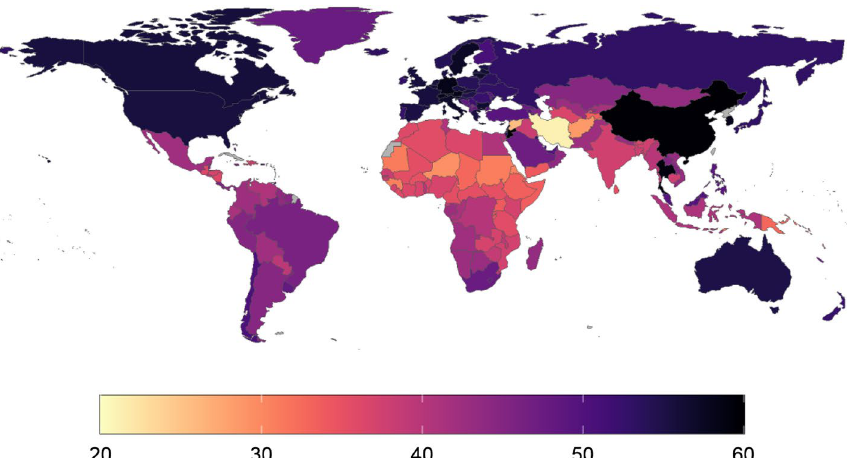
Figure 4. Heatmap of play inequality (PI), Oct 2020–2021. Countries/regions with no data in grey colour. This map was generated using ggplot in R (v4.0.2). Code for reproducing these maps is available at the OSF repository associated with the